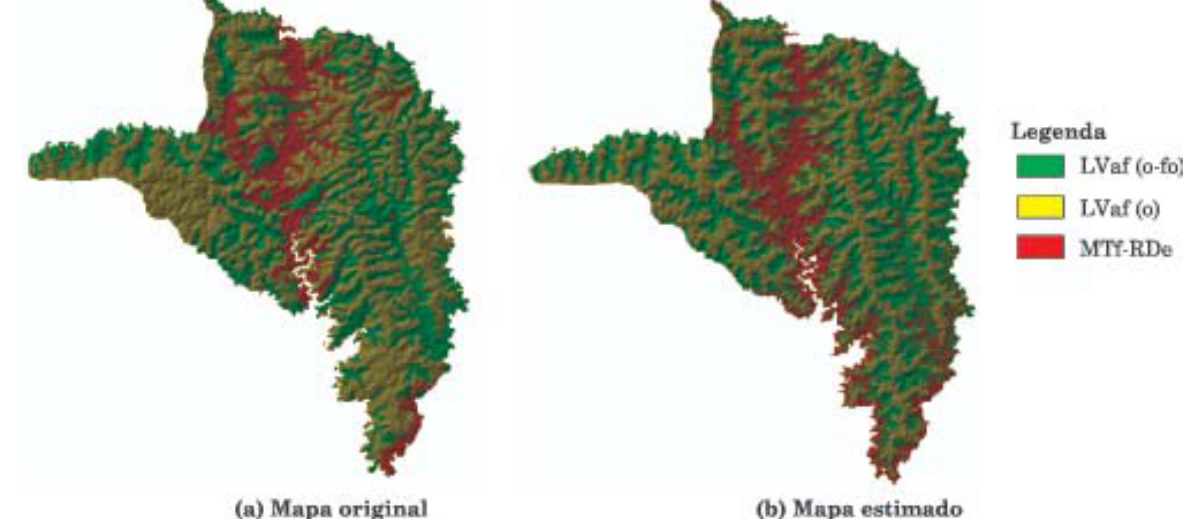
Figura 2. Mapa de solos com legenda simplificada a partir do levantamento de campo (a) e mapa de solos estimado por regressões logísticas (b) nos municípios de Ibirubá e Quinze de